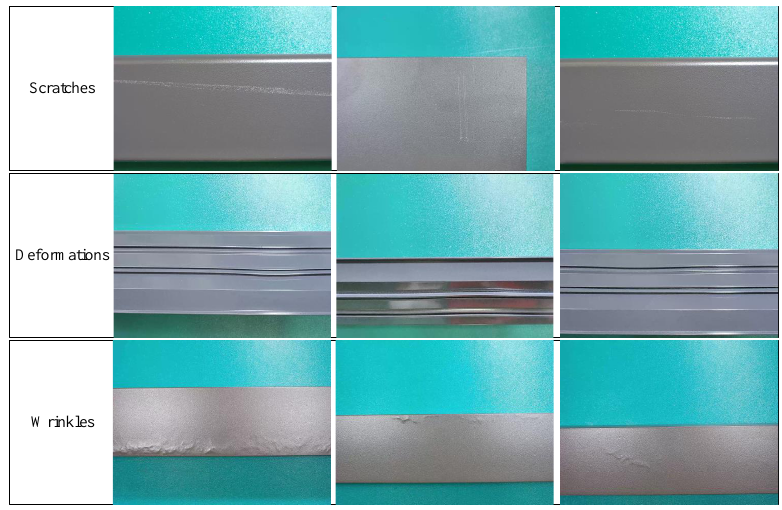
Figure 5. Tianchi dataset.